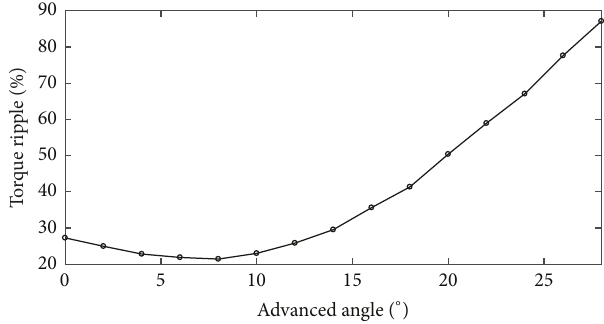
Figure 7: Torque ripple changing with advanced